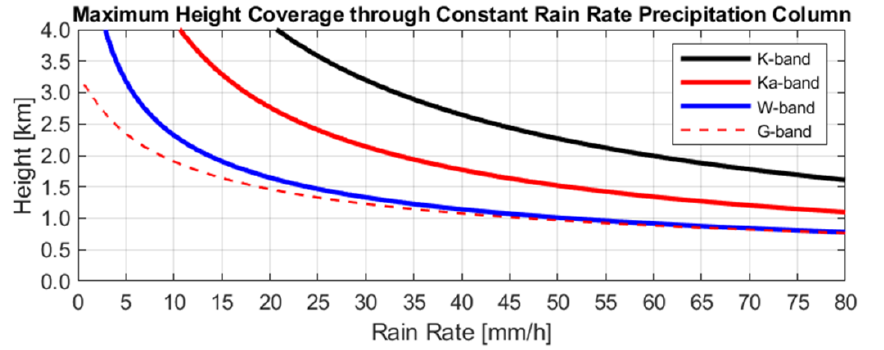
Figure 10. Estimated maximum VPR path length as a function of constant rain rate and for radar K-, Ka-, W-, and G-bands. Maximum height is defined when the SNR drops 40 dB from the maximum pre-saturation SNR observed at 500 m. Simulation parameters mimic W-band WACR as deployed in GoAmazon. Table 5. Rain rates [mm h −1 ] of constant rain rate precipitation shafts that extinguish the return sig- nal for different path lengths and for radar X-, Ku-, K-, Ka-, W-, and G-bands. Calculations based on 40 dB radar receiver dynamic range with maximum 𝑆𝑁𝑅 observed at 500 m. Simulation parameters mimic W-band WACR as deployed in GoAmazon and include atmospheric gas attenuation in the ITU reference atmosphere.